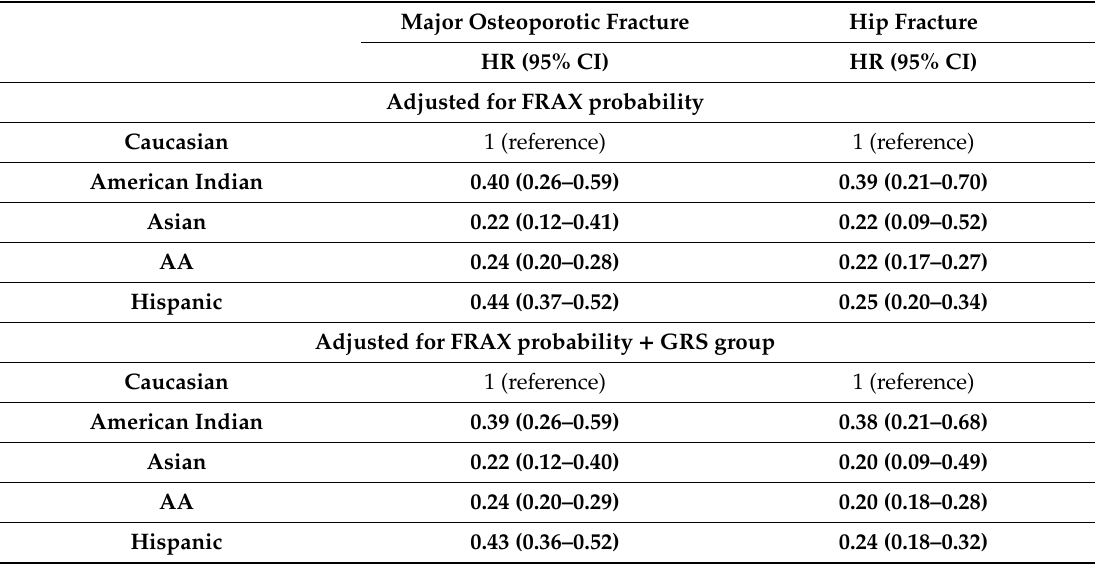
Table 3. Hazard ratios (HR) with 95% confidence interval (CI) for outcomes of incidence fracture according to race, adjusted for FRAX score: Results of multivariate Cox proportional hazard